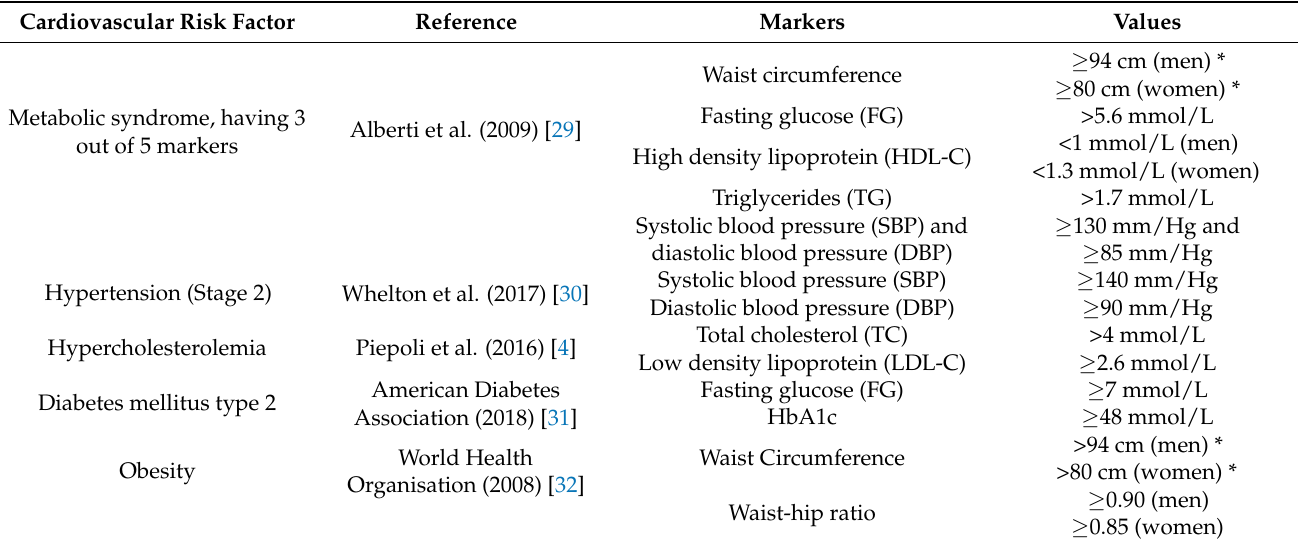
Table 1. Definitions of cardiovascular risk factors